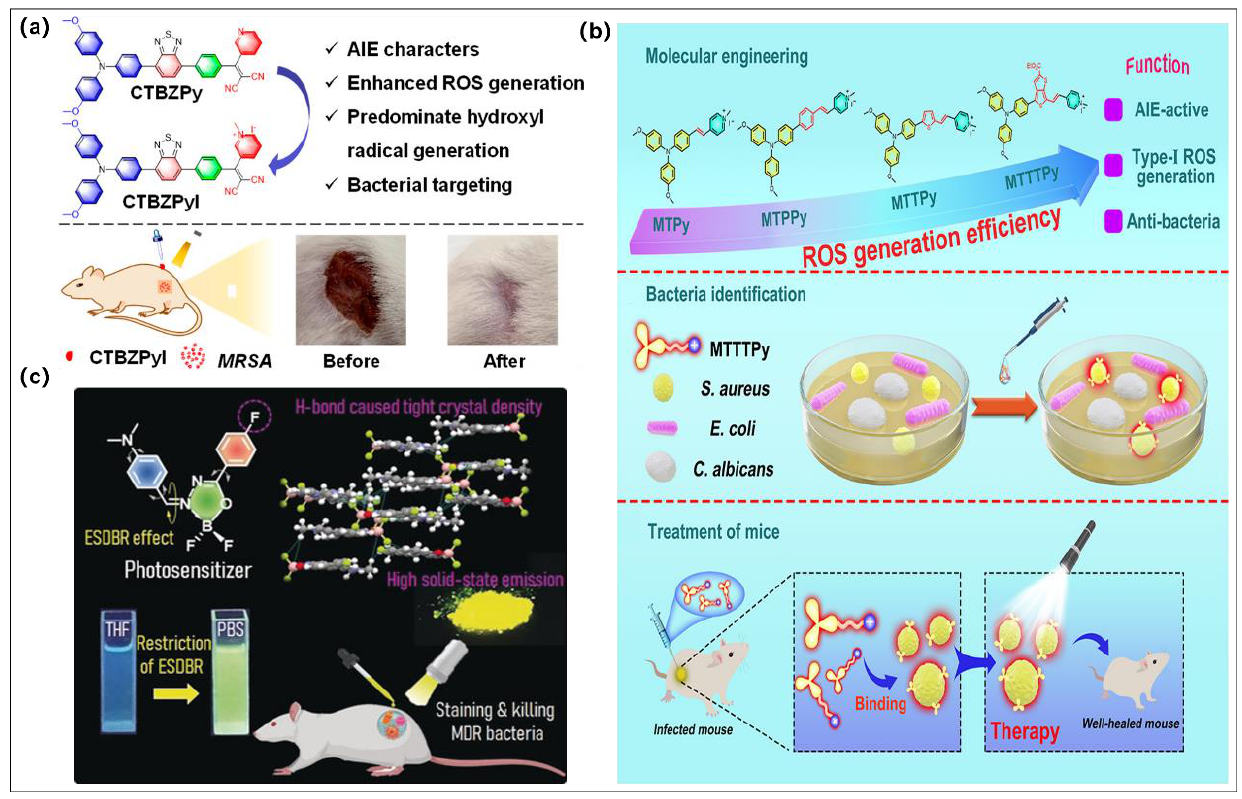
Figure 8. ( a ) Molecular structure of CTBZPy and CTBZPyI and the fast wound-healing effect of CTBZPyI . Reprinted with permission from [55]. ( b ) Molecular structures of four AIE PSs and schematic diagram of MTTTPy -mediated PDT for efficiently eradicating Gram-positive bacteria both in vitro and in vivo. Reprinted with permission from [102]. ( c ) Chemical structure of DMA-AB-F and schematic illustration of DMA-AB-F used for efficient staining and killing multidrug-resistant bacteria. Reprinted with permission from [103].